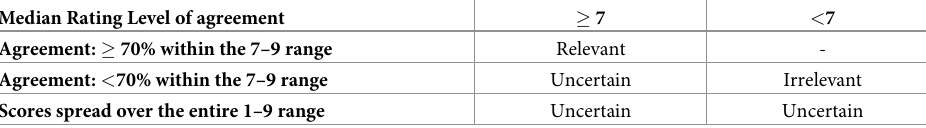
Table 1. Classification of competencies based on median scores and levels of